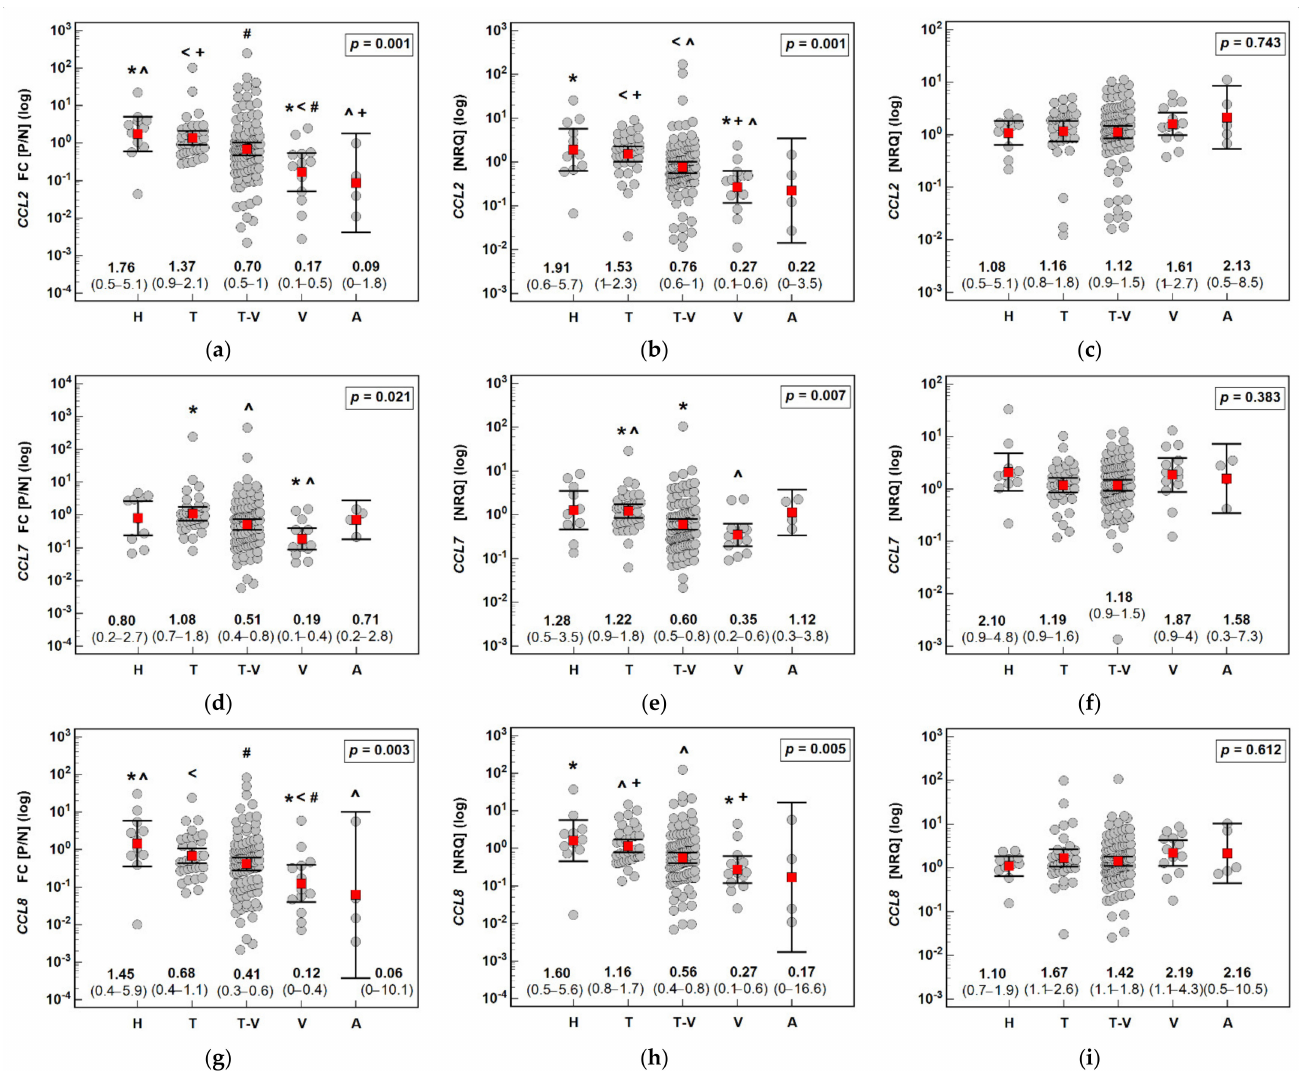
Figure 5. Effect of the polyp type on the expression (mRNA) of MCP chemokines in patients with colorectal polyps: ( a ) fold change (FC) in CCL2 expression between the polyp and normal mucosa (P/N); ( b ) CCL2 expression in a polyp; ( c ) CCL2 expression in normal tissue; ( d ) fold change (FC) in CCL7 expression between the polyp and normal mucosa (P/N); ( e ) CCL7 expression in a polyp; ( f ) CCL7 expression in normal tissue; ( g ) fold change (FC) in CCL8 expression between the polyp and normal mucosa (P/N); ( h ) CCL8 expression in a polyp; ( i ) CCL8 expression in normal tissue. Data analyzed as logarithms using one-way ANOVA with a Student–Newman–Keuls post hoc test and presented as means with 95% confidence intervals (red squares with whiskers and numbers below dot plots). Significant ( p < 0.05) differences between groups (identified in post hoc analysis) are indicated by the same symbol type (*, ˆ, <, +, #). NRQ: normalized relative quantity; H: